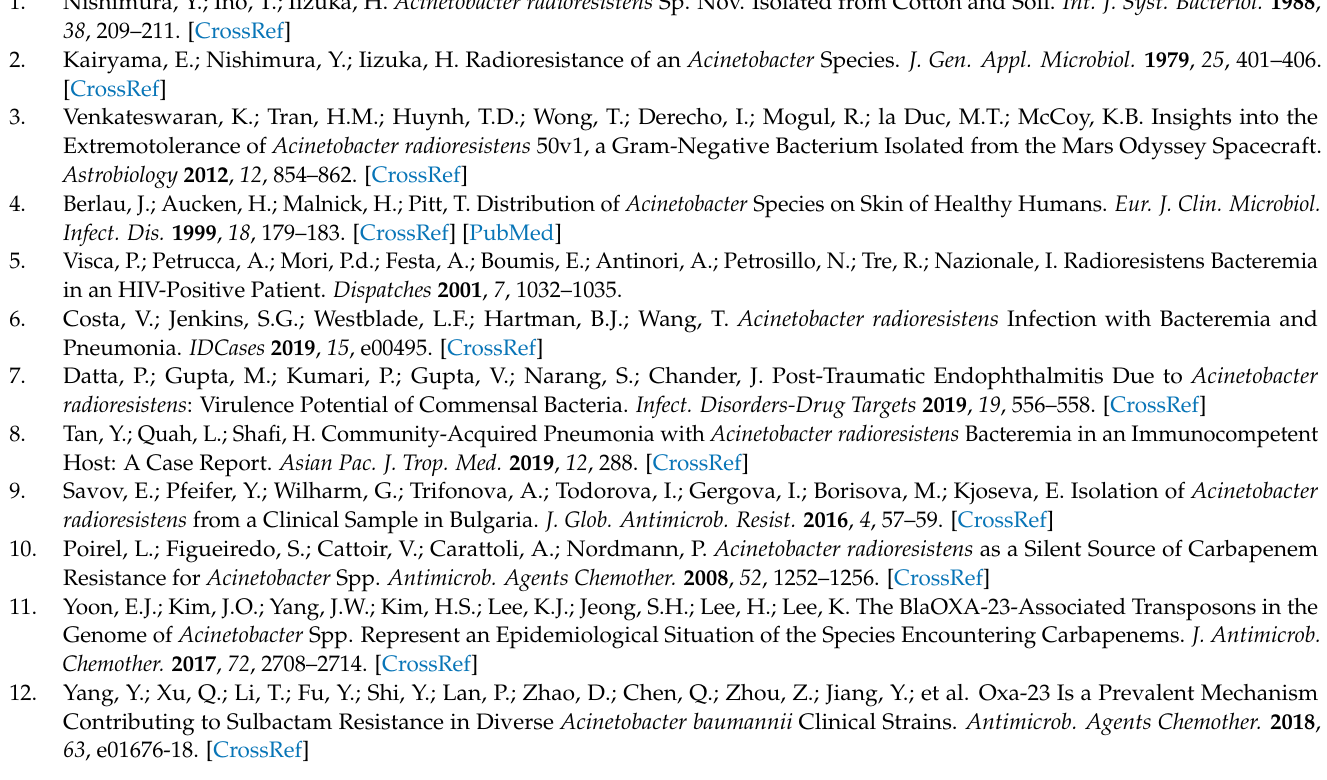
Table S2: PCR cycling protocol rpoB , Table S3: PCR protocol 16S rRNA , Table S4: Results obtained from VITEK